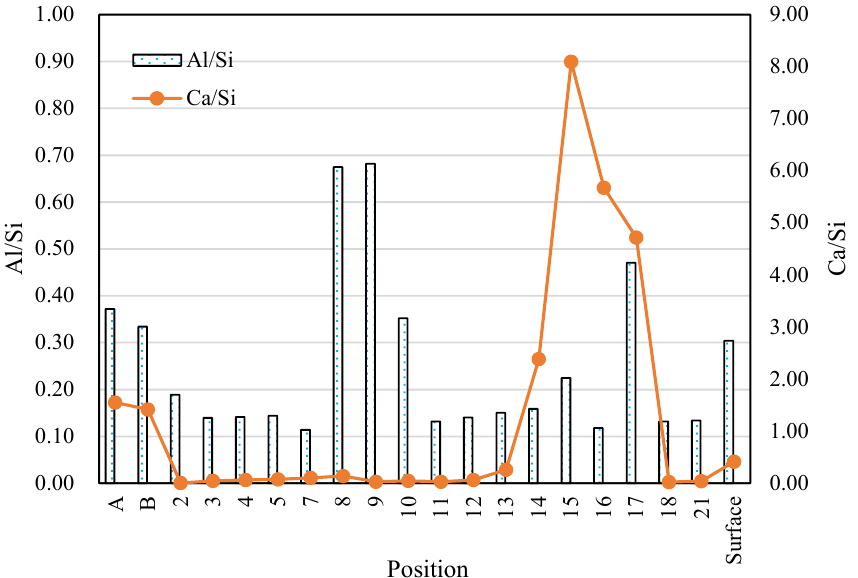
Figure 21. Atomic ratios at the outer and inner areas (A, B: average values of each inner area, see Figures 15b and 18; Numbers: analysis results of the points in the outer area; and Surface: average value of the outer area, see Figure 19).